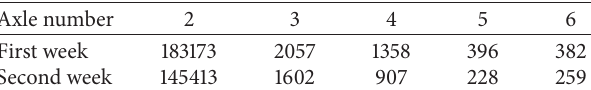
Table 1: Traffic flow distributions for vehicles with different axle numbers during two weeks.